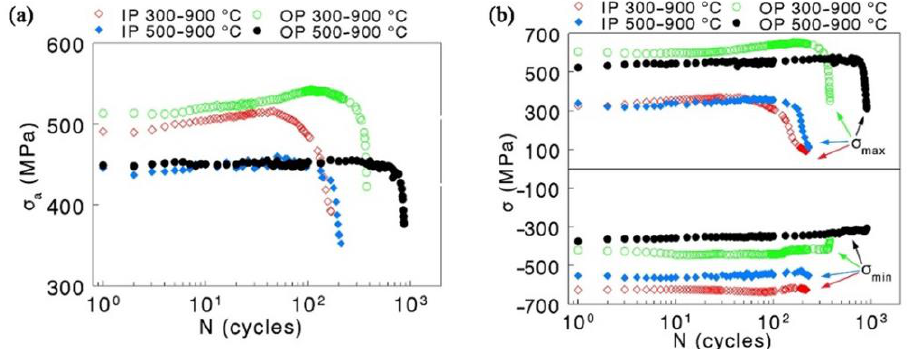
Figure 5. Stress response to applied mechanical strain ( a ) fatigue hardening/softening curves ( b ) evolution of maximal and minimal stresses during the TMF test.